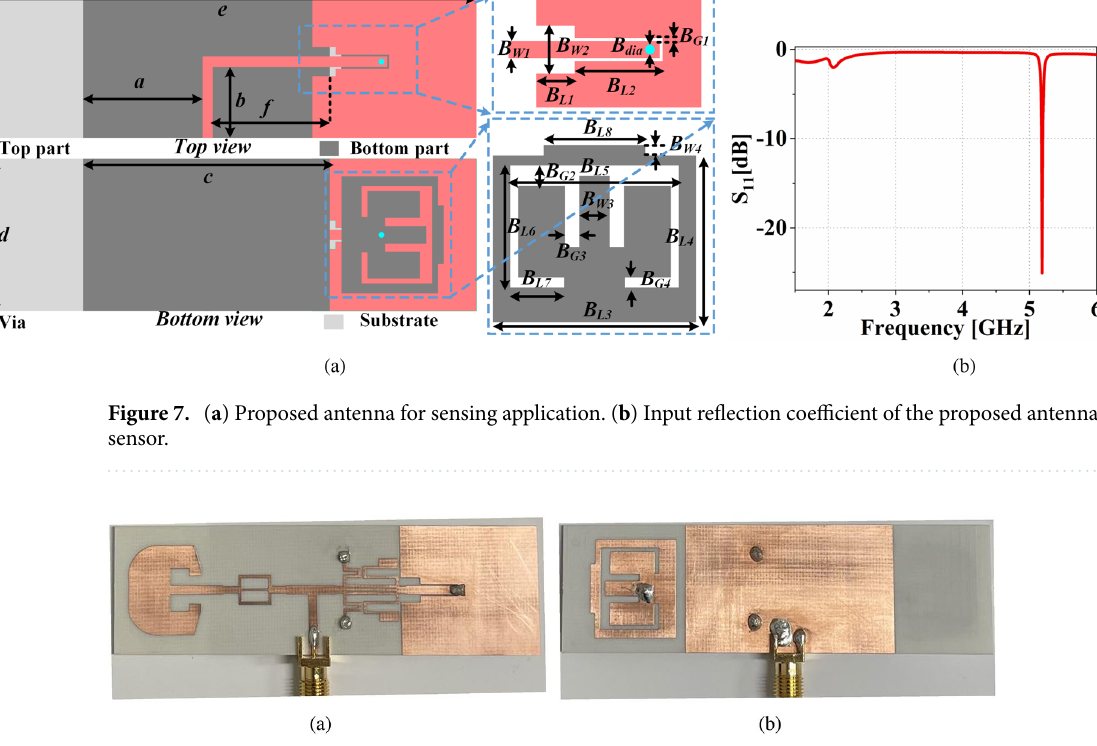
Figure 8. Fabricated prototype of the proposed dual-functional antenna system. ( a ) Top view, ( b ) bottom